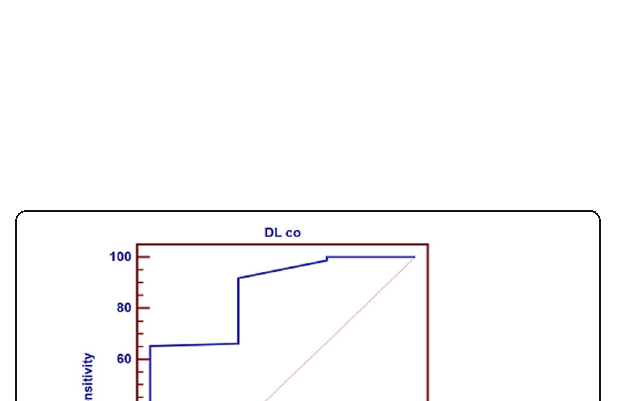
Table 8 Correlation between degree of diffusion lung capacity for carbon monoxide and degree of total Warrick ’ s score DLCO-SB Test Mild